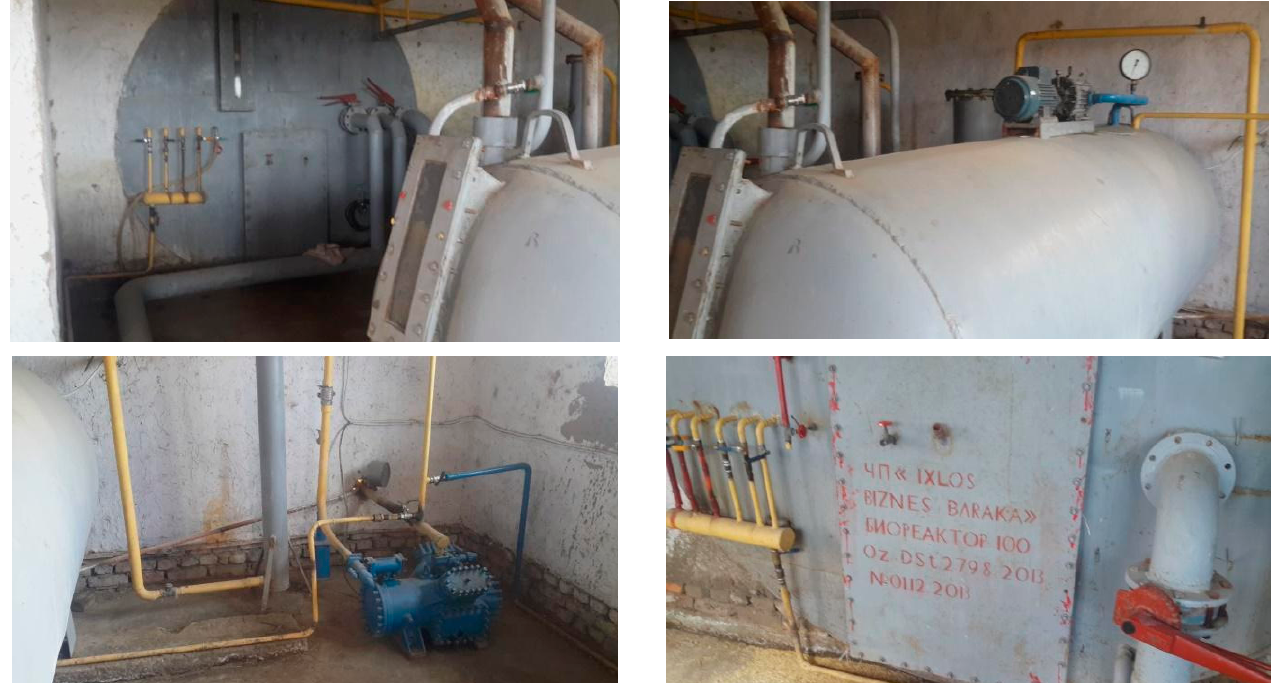
Figure 2. Biogas plant of the Agrofirma.